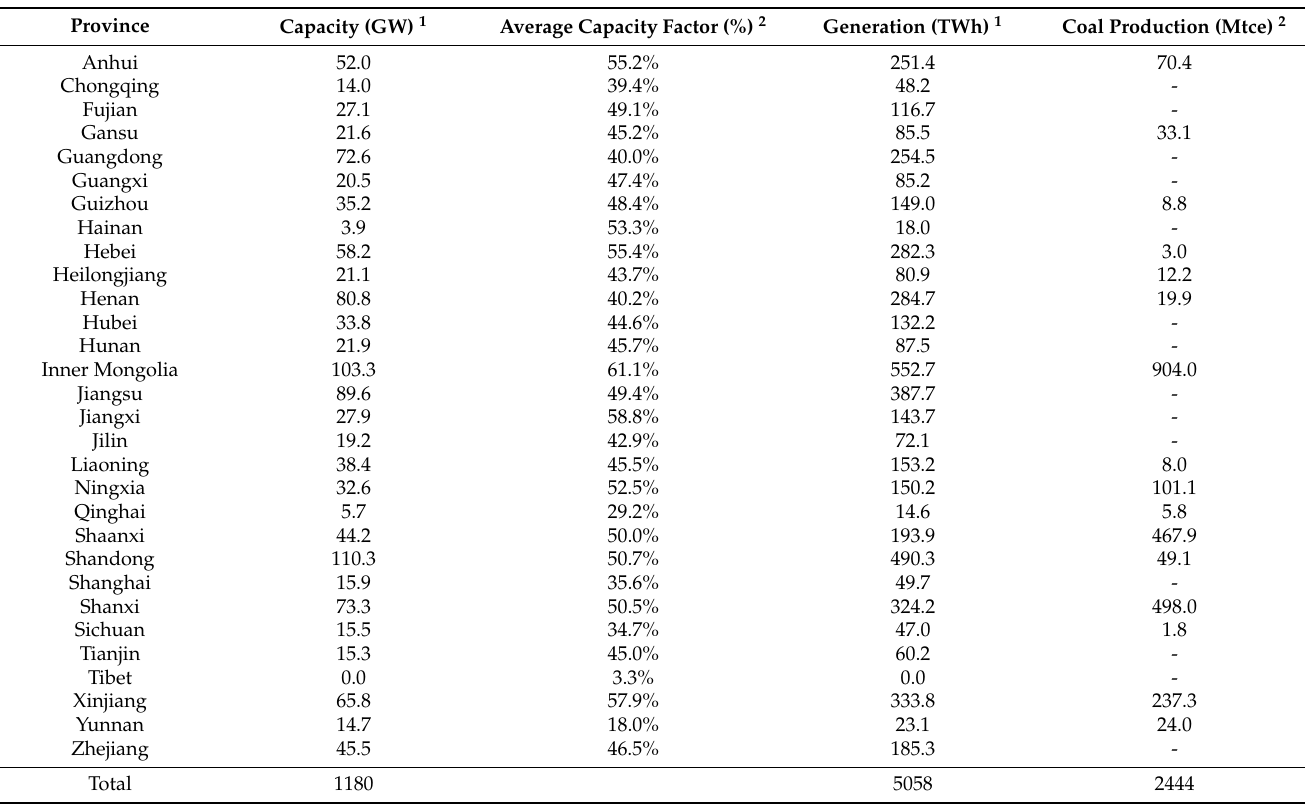
Table 1. Coal capacity, generation, and production statistics by province (B scenario,